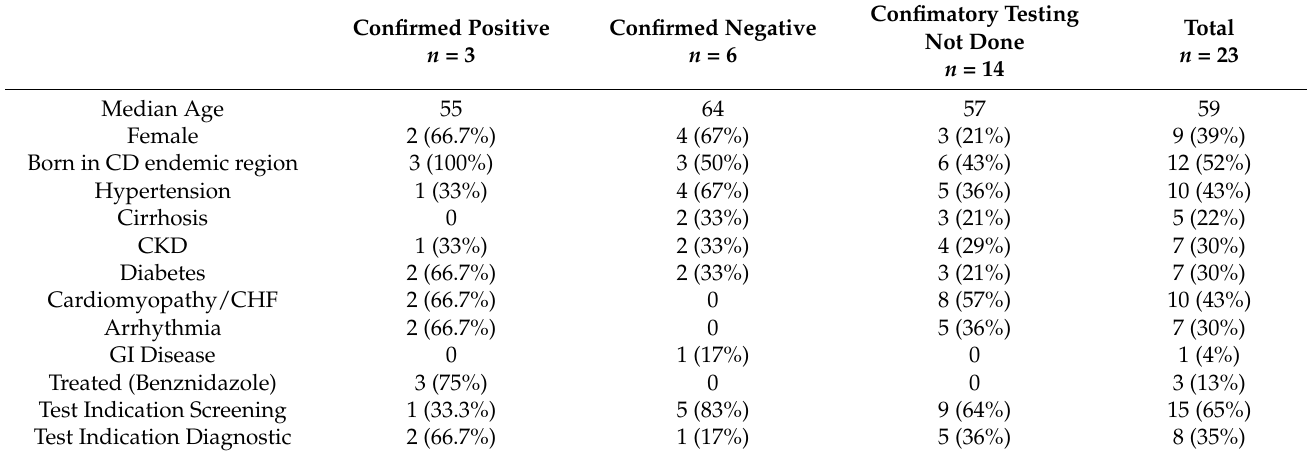
Table 1. Characteristics of patients with positive Trypanosoma cruzi IgG 1